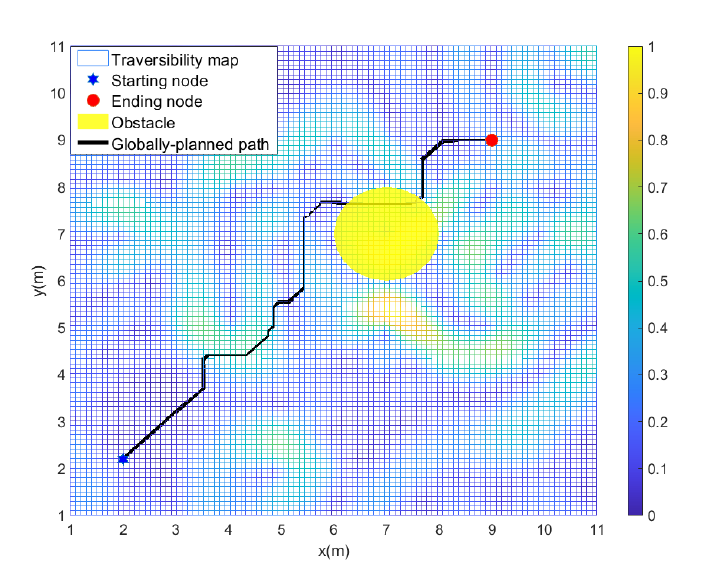
Figure 3. The globally planned path and locally detected obstacle in scenario 1.